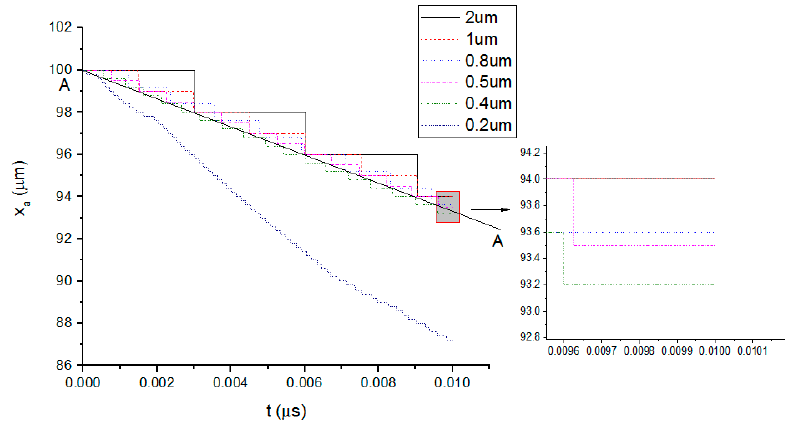
Figure 4. Effect of space step δ x on the ablation boundary at time step δ t = 0.001 ns.